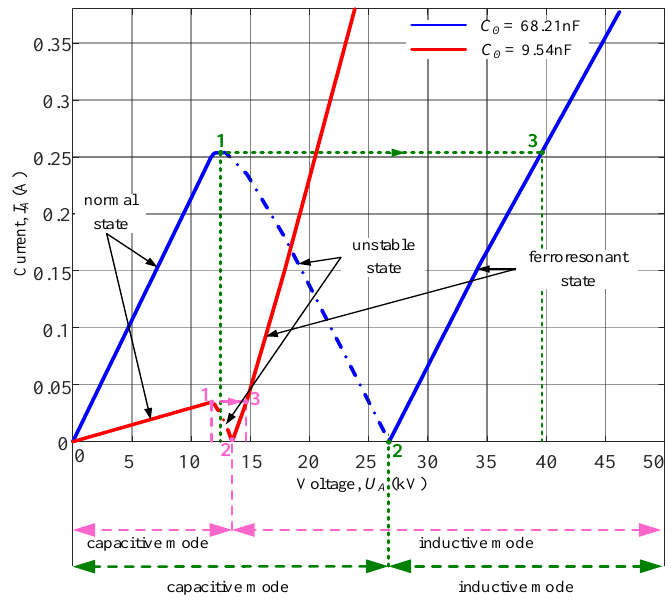
Figure 2. Current-voltage characteristic of parallel capacitance C 0 and nonlinear inductance L µ connection.